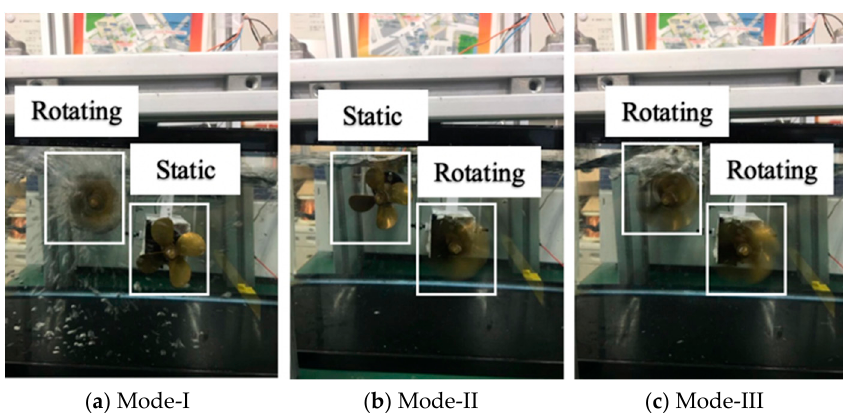
Figure 7. Experimental set up for a moving target identification. Micromachines 2020 , 11 , x